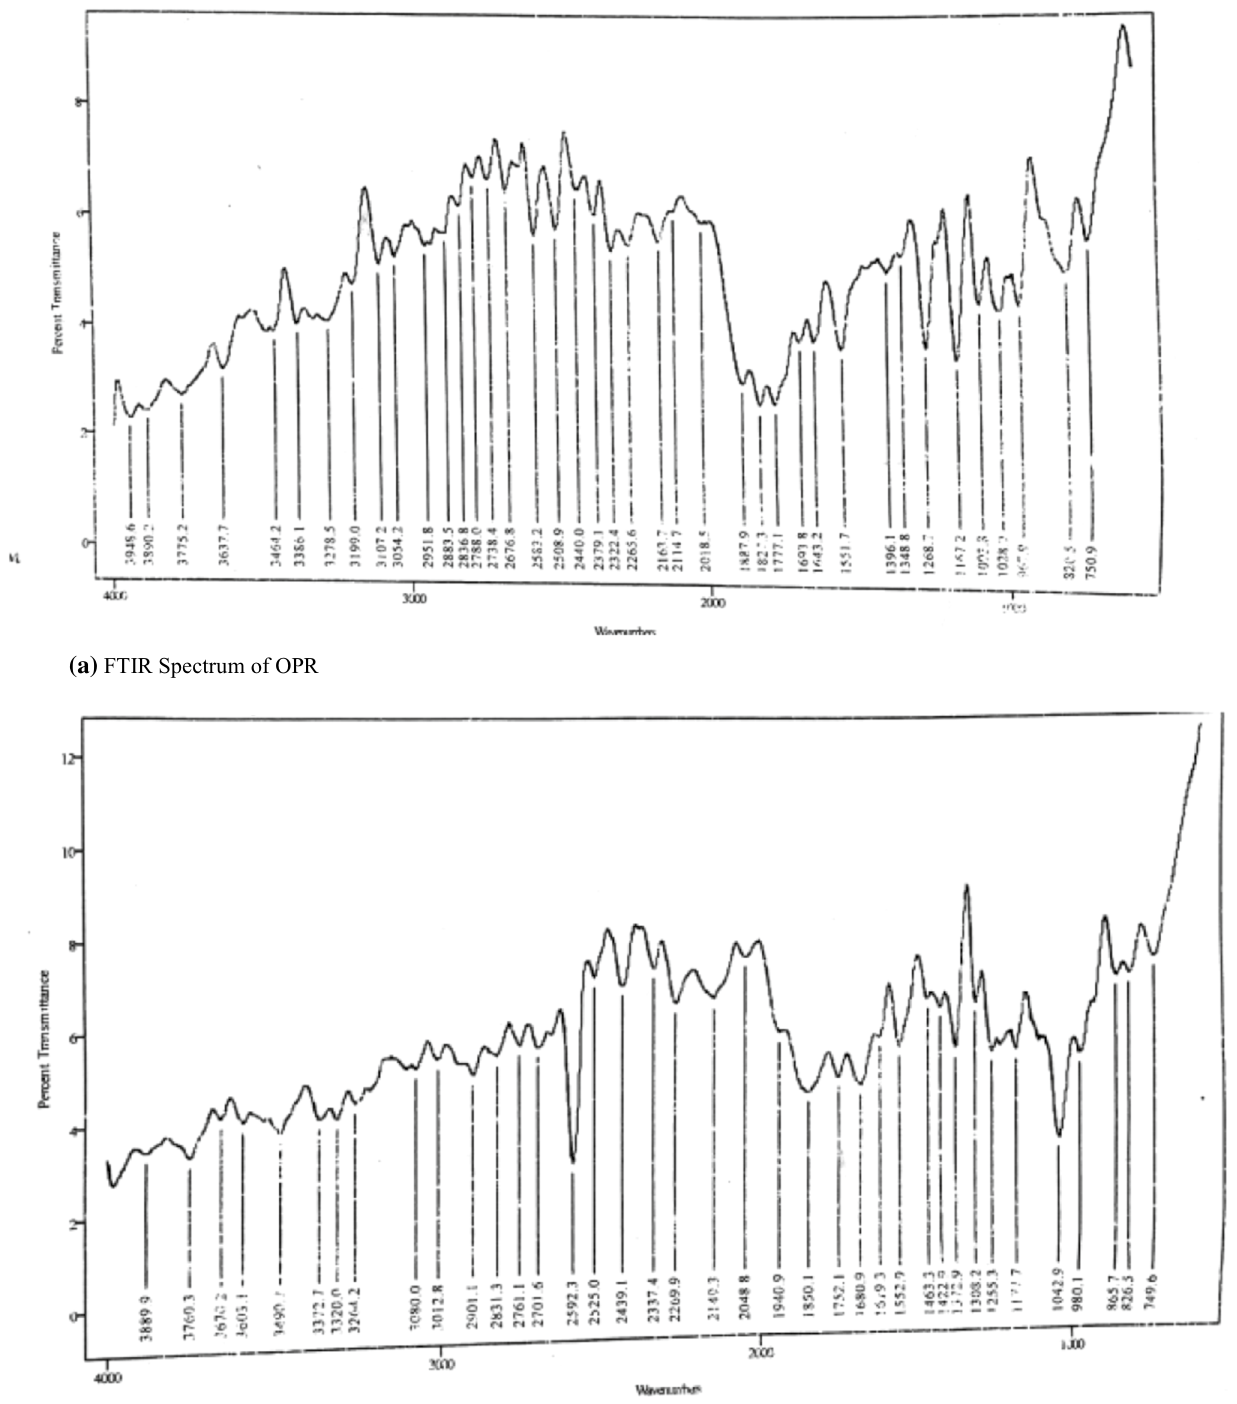
Fig. 3 a FTIR Spectrum of OPR. b FTIR Spectrum of